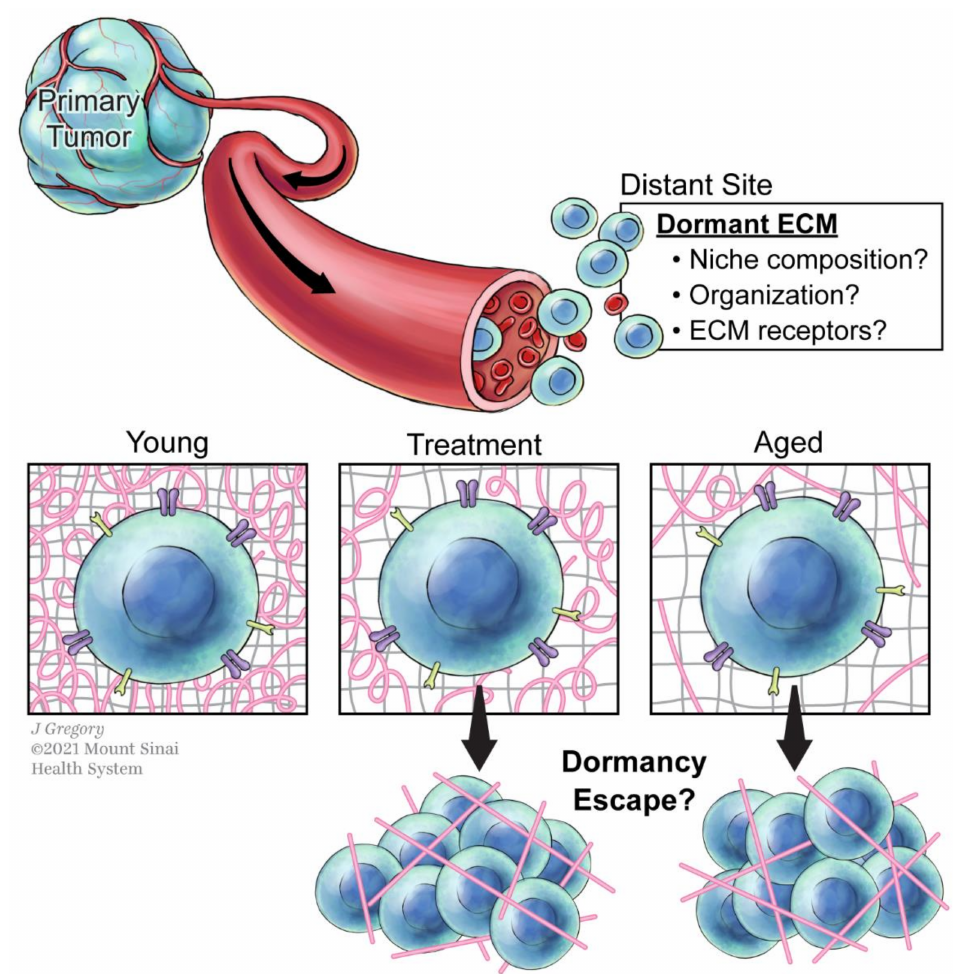
Figure 2. ECM effects on cancer cells during tumor dormancy. Cancer cells (represented in blue) leave the primary tumor and colonize a secondary distant site. In this new site, they encounter new environments that will vary in ECM composition and organization. The repertoire of receptors in these cells may determine their fate, dormancy, or proliferation. Cancer treatments and aging are factors that can influence the ECM architecture of a tissue and influence the escape from dormancy. Collagens are represented in pink, proteoglycans in grey, and ECM receptors in purple and